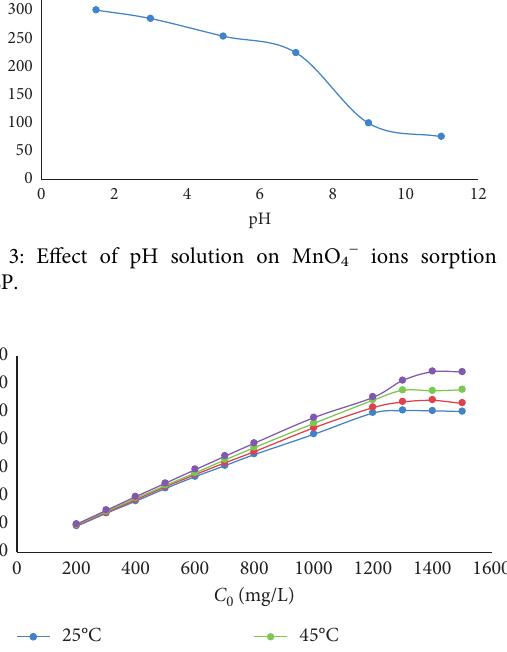
Figure 4: Effects of temperature and MnO sorption efficiency of